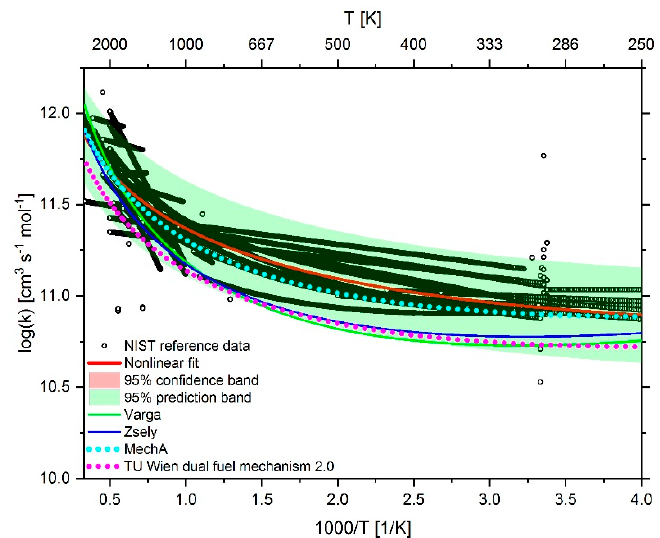
Figure 21. Comparison of the reaction rate coe ffi cient of reaction 25 (CO + OH ↔ CO 2 + H) of MechA, TU Wien dual fuel mechanism 2.0, Zsely et al. [220], Varga et al. [221] as well as the fitted rate coe ffi cient using reference data from the NIST database.